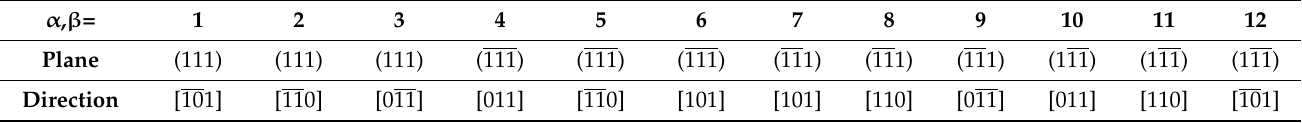
Table 1. FCC slip system designation.